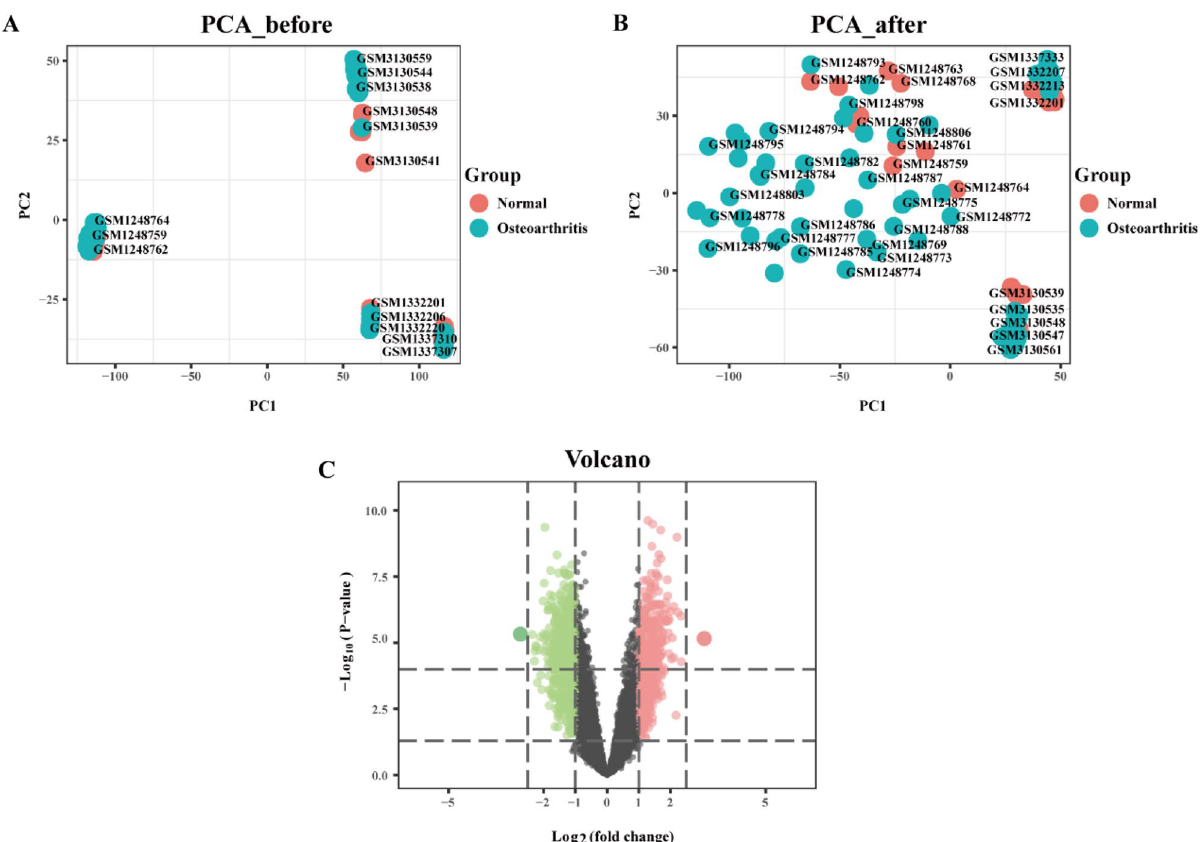
Figure 2. Two-dimensional PCA cluster plot before and after sample correction and volcano plots of DEGs. ( A , B ) Figure shows two-dimensional PCA cluster plots before and after correcting for inter-batch differences removed for GSE51588, GSE55235, GSE55457, and GSE114007, respectively. Blue represents the osteoarthritis group and red represents the normal control group. ( C ) DEG volcano plot; red represents up-regulated differentially expressed genes and green represents down-regulated differentially expressed